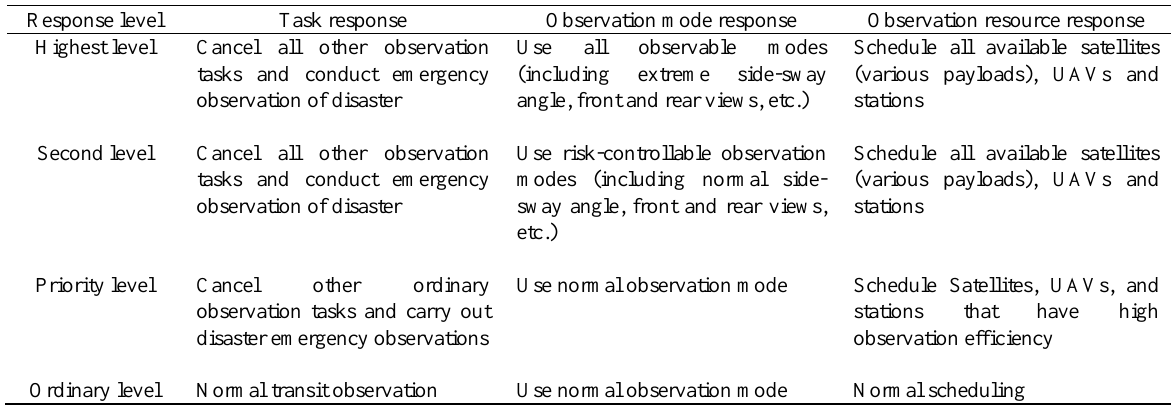
Table 1. The workflow tasks planning of different response